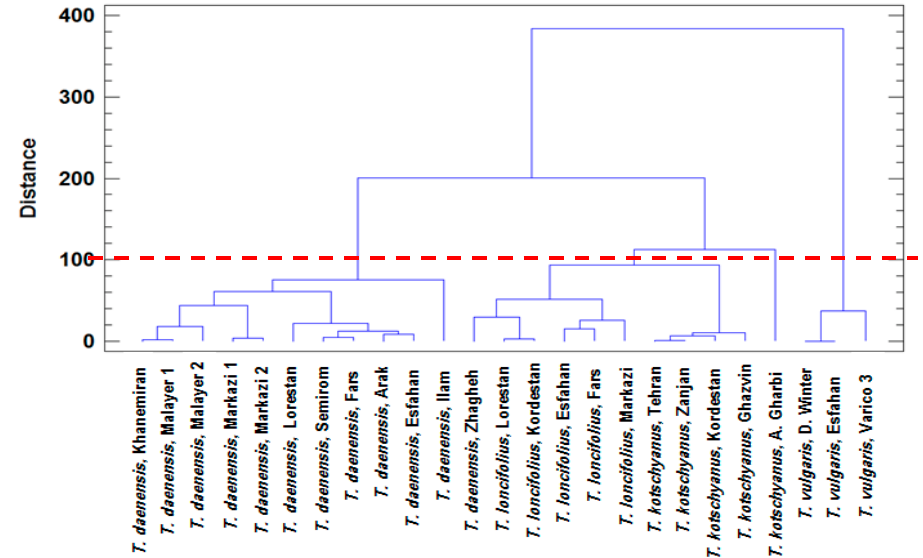
Fig. 1: Clustering different ecotypes and species of Thymus based on morphological traits using WARD